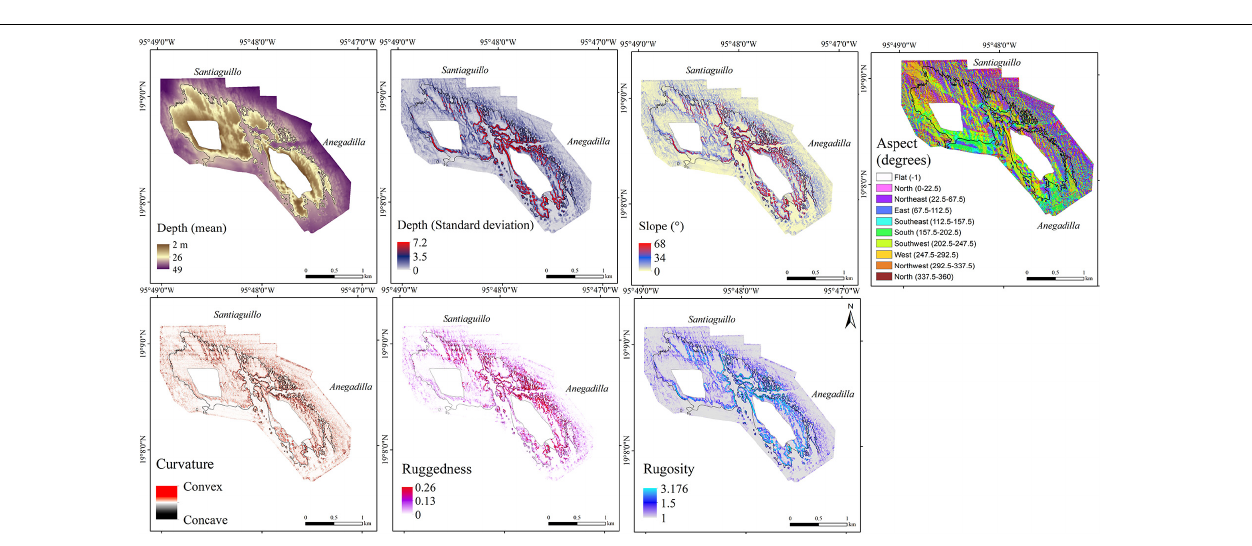
map describing the most conspicuous geomorphologic